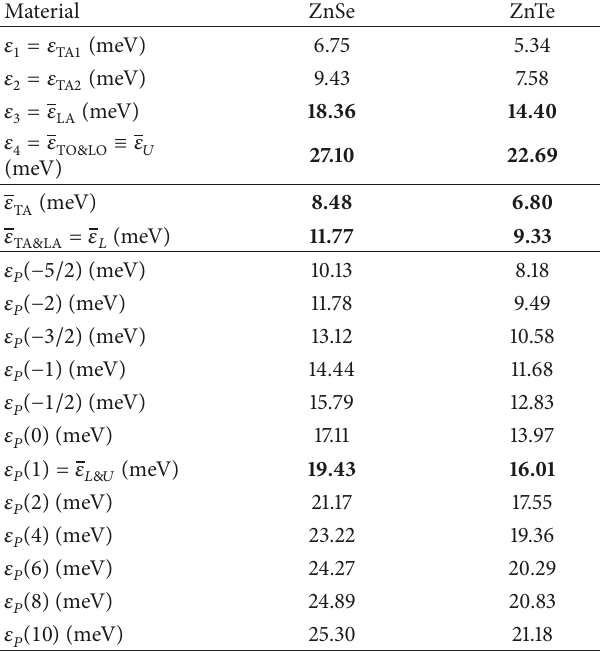
Table 5: Phonon energy values for the 4 discrete (Einstein) oscilla- tors, 𝜀 𝑛 = 𝑘 𝐵 Θ 𝑛 ( 𝑛 = 1 to 4, corresponding to the Θ 𝑛 values given in Table 1), the average phonon energies for the TA phonon sections, 𝜀 (44), and the whole acoustic phonon energy sections, 𝜀 TA (45), including a series of equivalent (moment-related) phonon energies, 𝜀 𝑃 (𝑚) (due to (46) and